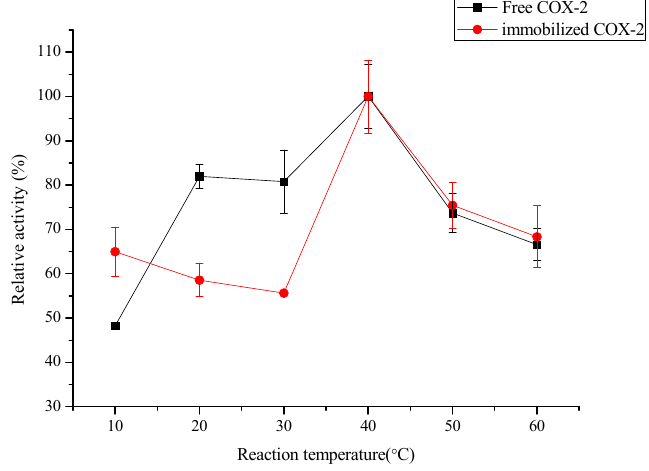
Figure 6. Effect of temperature on the biocatalytic activity of the immobilized COX-2 and free COX-2 ( n = 3).